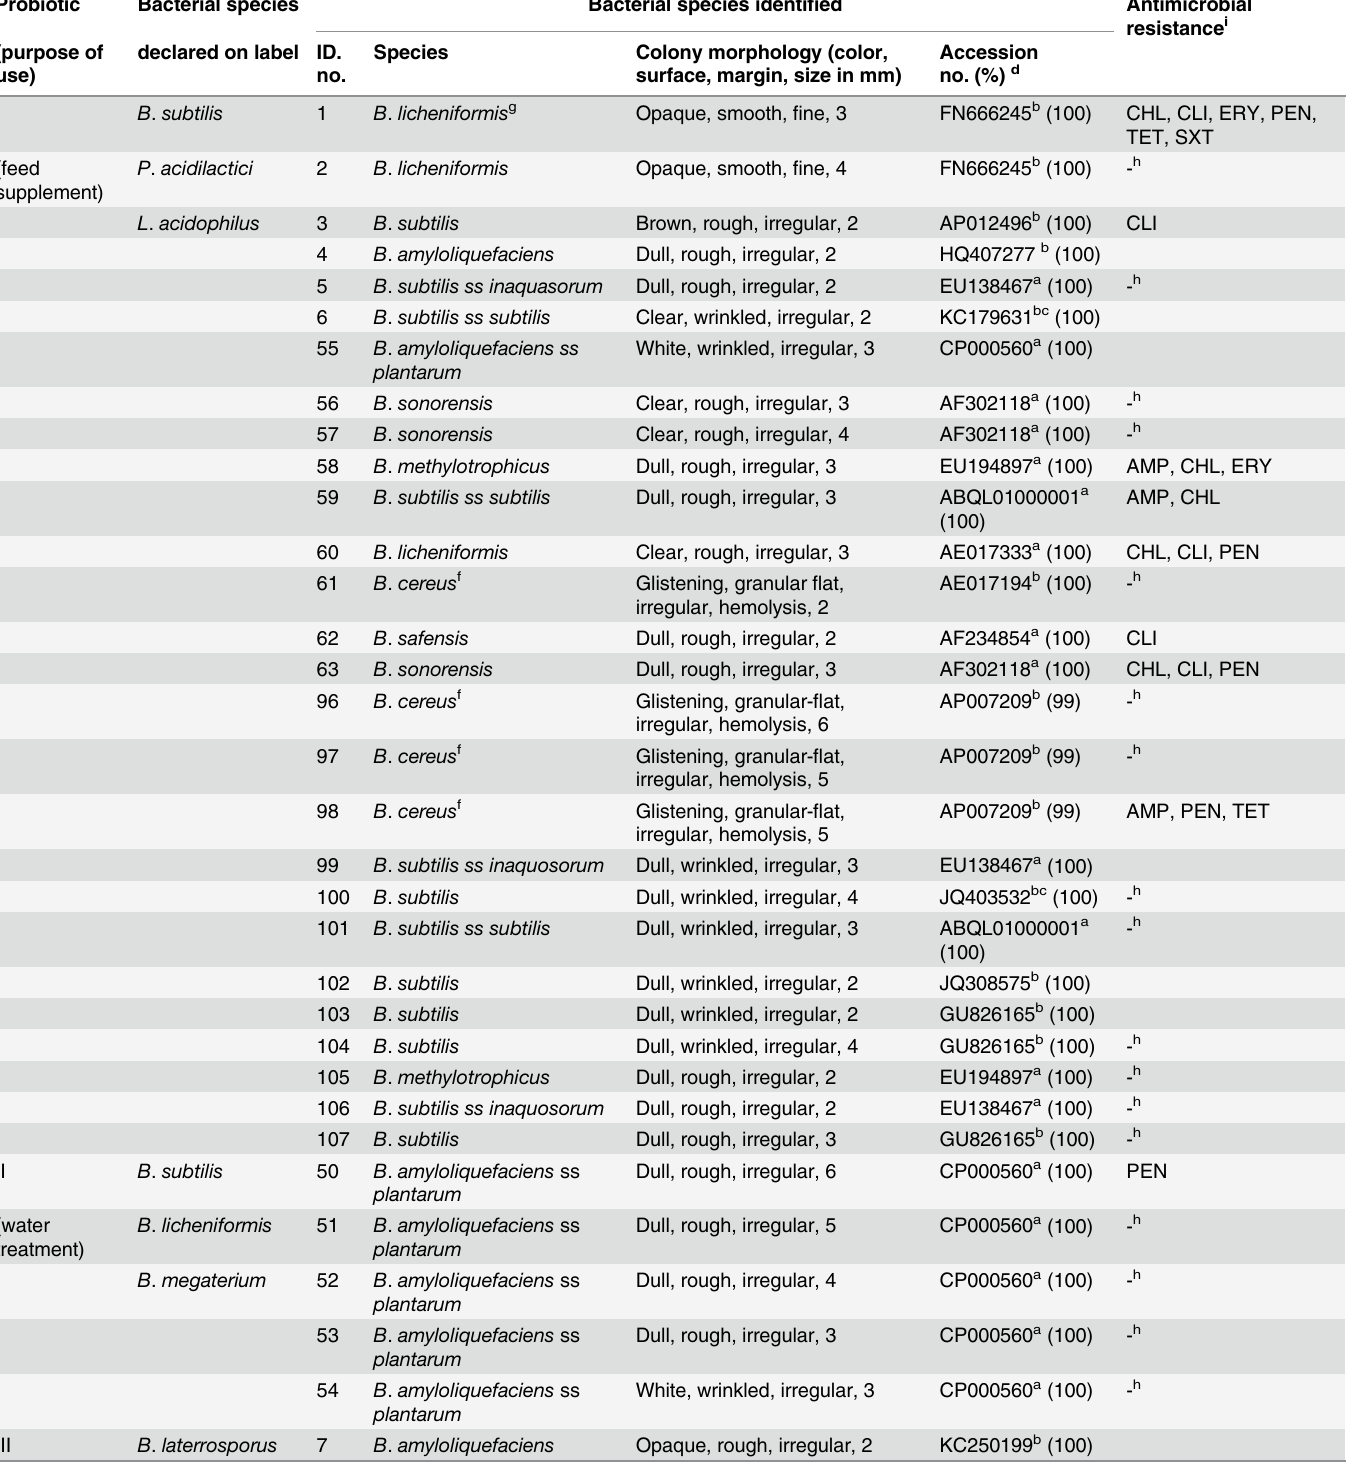
Table 2. Bacterial species isolated from probiotic products after incubation on blood agar for 24 h at 30°C and subsequent identification by 16S rRNA analysis and their susceptibility to antimicrobials. Probiotic Bacterial species Bacterial species identi fi ed Antimicrobial